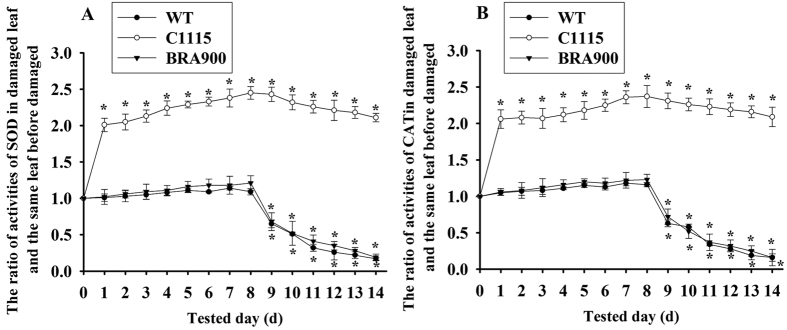
Change trend of SOD (A) and CAT (B) activities in different cassava cultivars damaged by T. cinnabarinus. The changes in SOD or CAT activities were presented as the ratio of the activities in 1 d to 14 d–damaged leaves and the same leaf before being damaged by T. cinnabarinus (0 d). Asterisk indicated activities of SOD and CAT in damaged leaves were significantly different from those in undamaged leaves (Student’s t-test, P < 0.05).